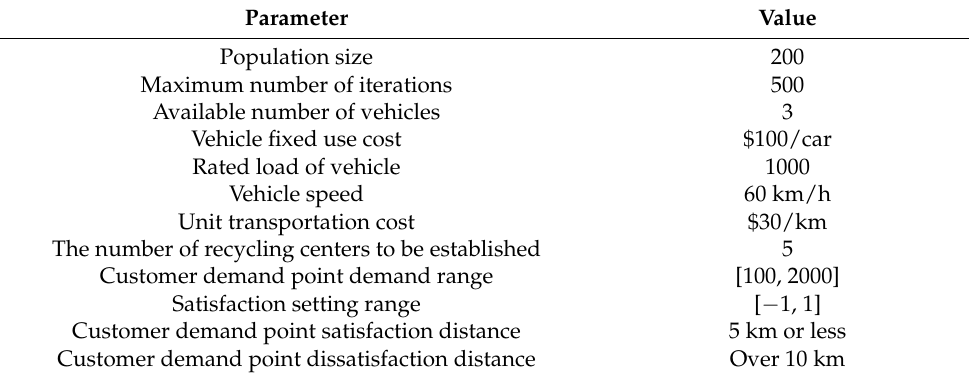
Table 4. Simulation